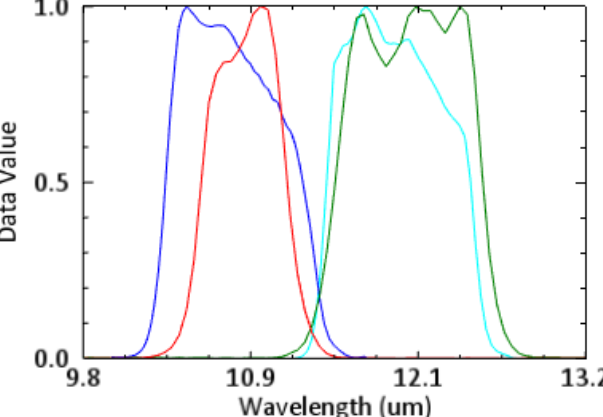
Figure 3. Spectral of thermal infrared channels of Landsat8 and AVHRR made by ENVI5.3 .